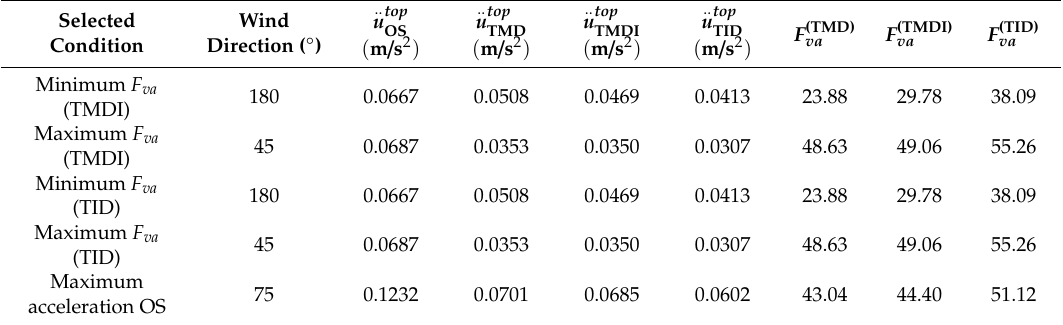
Table 5. Vibration-mitigation e ff ects in terms of top-floor acceleration response for some loading